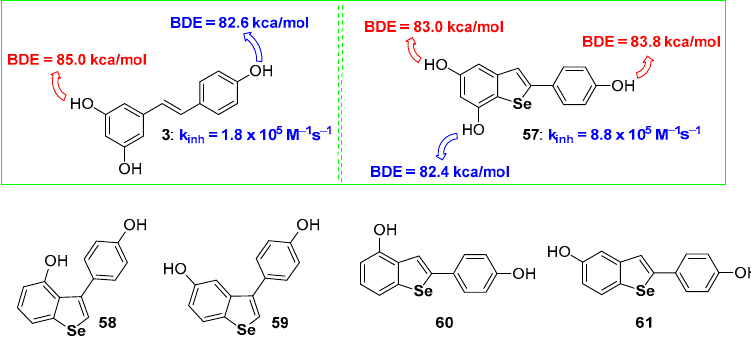
Figure 15. A selection of benzo[ b ]selenophenes antioxidants reported so far.